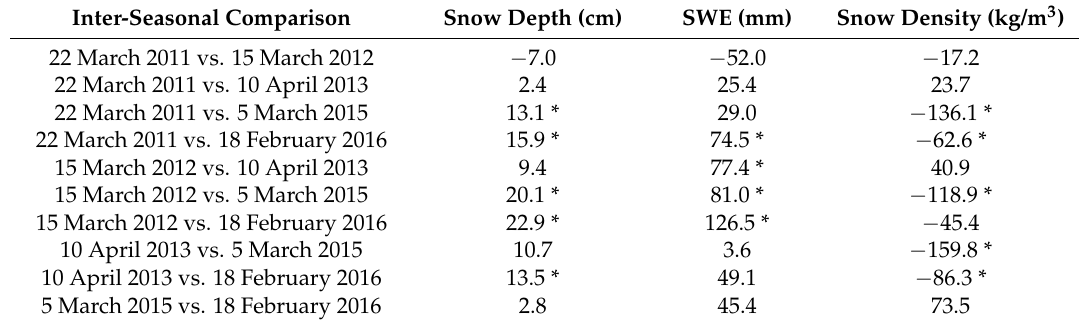
Table 4. Multiple, inter-seasonal comparisons of mean snow depth, snow water equivalent (SWE), and snow density of the ski slope snowpack, measured at the end of the five winter seasons. Displayed are the estimated differences between each pair of means.